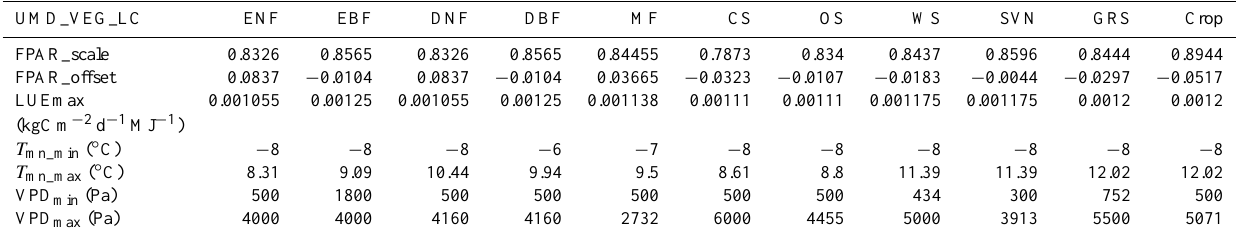
Table 1. Biome property look-up table (BPLUT) for GPP algorithm with ERA-Interim and NDVI as inputs. The full names for the University of Maryland land cover classes (UMD_VEG_LC) in the MOD12Q1 data set are evergreen needleleaf forest (ENF), evergreen broadleaf forest (EBF), deciduous needleleaf forest (DNF), deciduous broadleaf forest (DBF), mixed forests (MF), closed shrublands (CS), open shrublands (OS), woody savannas (WS), savannas (SVN), grassland (GRS), and croplands